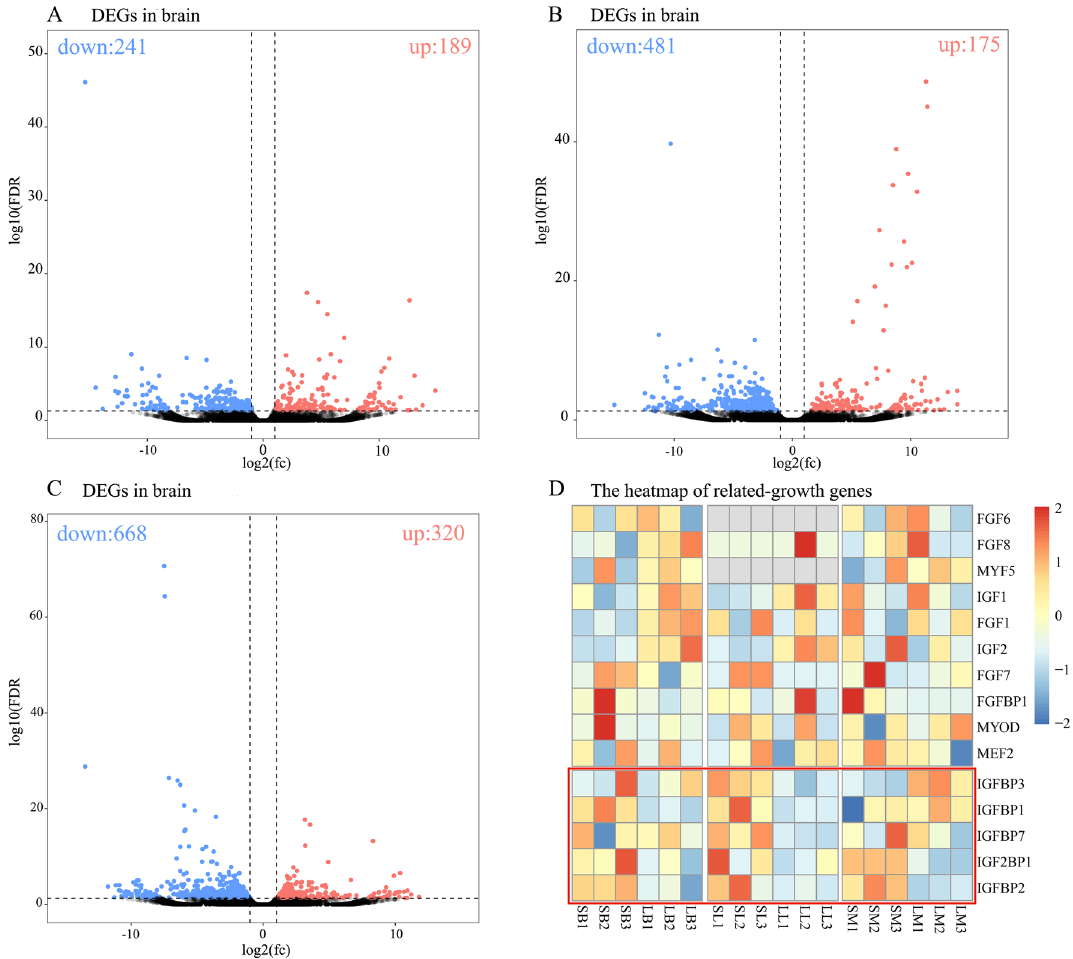
Figure 4. The high expressed genes (HEGs) of LG or SG loach. ( A – C ) the volcano map of HEGs in the brain, liver and muscle, respectively. ( D ) the heatmap of related-growth genes between LG and SG loach. LB, LL, LM: the brain, liver, and muscle of large group, SB, SL, SM: the brain, liver, and muscle of small group. FDR false discovery rate; fc fold It was also found in rainbow trout that the expression of lipid-metabolism-related genes was up-regulated in fast growth fish compared with slow growth fish, which was consistent with our findings 26 . In addition, the genes related to the growth were mainly involved in energy metabolism, carbohydrate and lipid metabolism, and cytoskeletal composition, which the similar expression pattern were also observed in the study of salmonid liver and muscle gene expression 27–29 . Generally, insulin-like growth factors (IGFs) were generally thought to be up-regulated in tissues of rapidly growing individuals, such as Nile tilapia ( Oreochromis Niloticus ) 30 , channel catfish ( Ictalurus punctatus ) 31 , and Arctic charr ( Salvelinus alpinus ) 32 . It was found in this study that the gene IGF1 and IGF2 were different in two groups, but the difference was not significant (FDR > 0.05), which was similar to previous studies 11,33,34 . However, IGFBP1 (insulin-like growth factor binding protein-1) of brain and liver and IGFBP7 of liver expressed in SG group were both higher than that in LG loaches in this study (FDR < 0.05; Fig. 4D). In a recent study of rainbow trout, it was also found that small fish had higher expression of IGFBP1 in the liver than in large fish 26 . Previous studies demonstrated that IGFBP1 could inhibit IGF binding to cell surface receptors and thereby inhibit IGF-mediated mitogenic and cell metabolic actions 35 . Likewise, overexpression of IGFBP1a/b in zebrafish would retard embryonic development and growth 36,37 . Therefore, in addition to having stronger metabolic activity, one of the internal factors for the fast growth of large fish may be related to the lower expression of IGFBP1 and IGFBP7 . The binding protein of IGFs genes (IGFBPs) are known to inhibit cell growth and differentiation by binding specifically IGFs 38,39 , which can be influenced by many factors. Previous studies have shown that fasting increases hepatic IGFBPs levels, and IGFBPs drops back to normal after refeeding 11,40 . Whether in large-scale farming or in the natural environment, the smaller individuals have lower social status, as well as mating and feeding rights 41,42 . We could speculate that it might be more difficult for small individual loach to obtain food in paddy fields culture environment, which led to its more delayed growth and development. Furthermore, the HEGs in SG fish were enriched in the pathways related to environmental information processing such as cell adhesion molecules (CAMs), ECM–receptor interaction and Rap1 signalling pathway; cellular processes such as tight